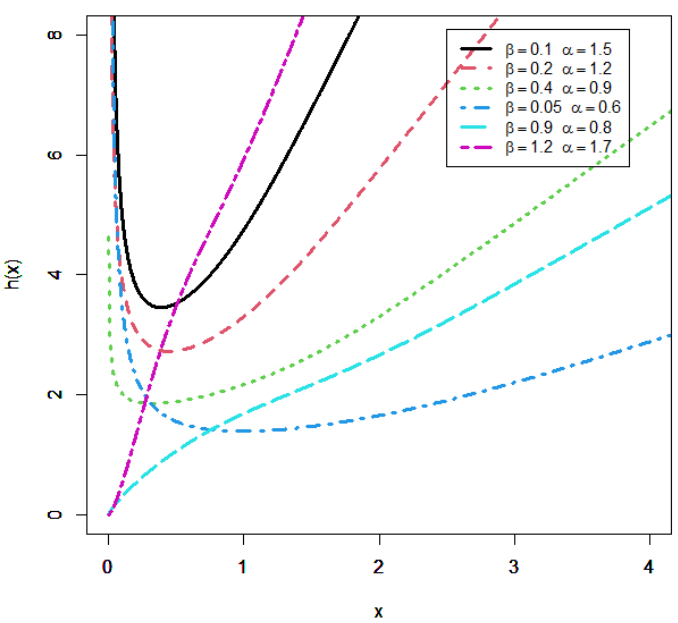
Figure 2. The hrf plots of the KMB X model.